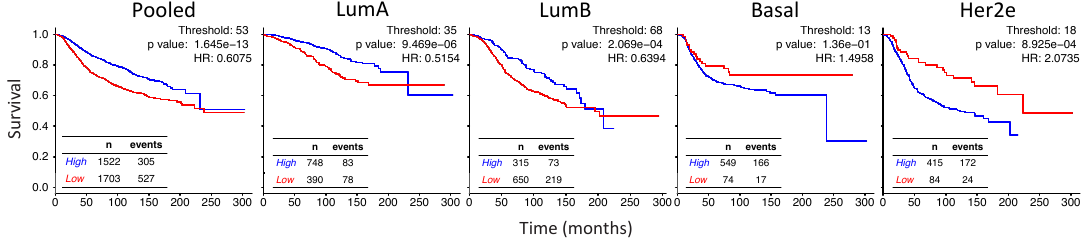
Figure 7. GJA1 is associated with a diverging outcome depending on breast cancer subtype. The Kaplan–Meyer plots show survival curves for patients with breast tumors expressing either high (blue) or low (red) levels of GJA1 mRNA in pooled tumors or in individual intrinsic subtypes. TCGA, NKI, Vanvliet and both Curtis datasets were aggregated for the analysis. The best cutoff was determined as the percentile lending the lowest log rank test p value (Figure A12) and was 53 in Pooled tumors, 35 in luminal A (LumA) tumors, 68 in luminal B (LumB), 13 in Basal and 18 in Her2e